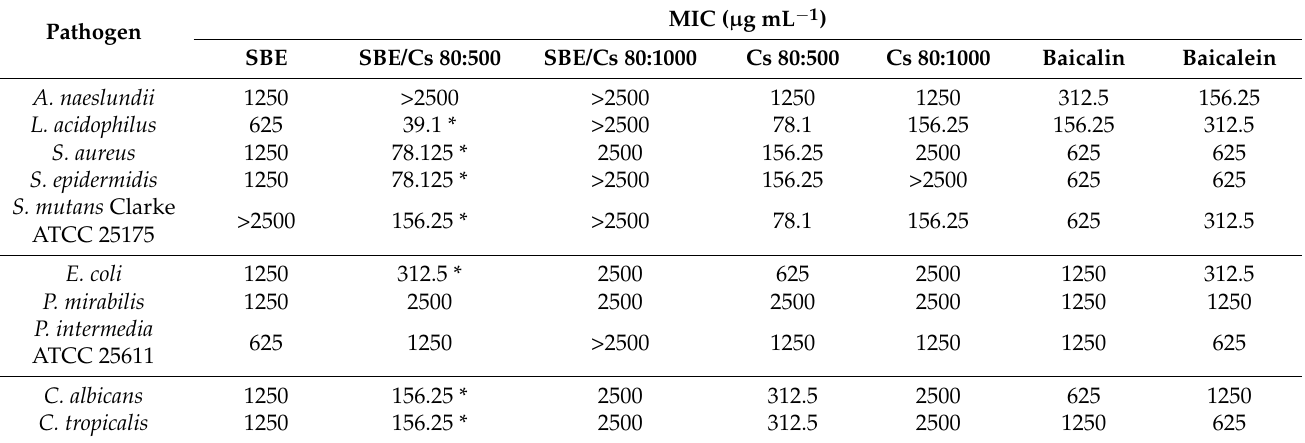
Table 2. Antimicrobial activity of standards, S. baicalensis radix extract, and binary